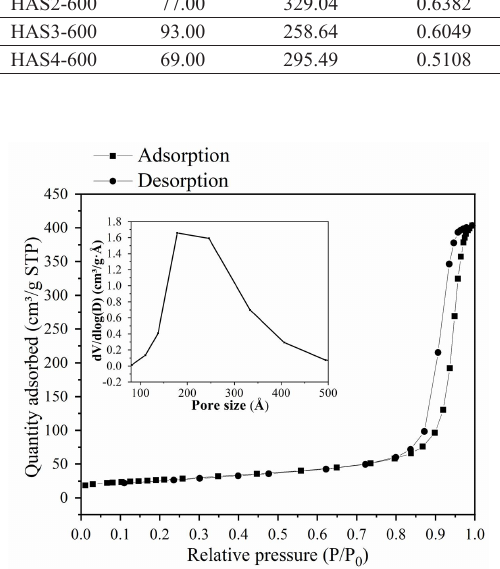
of the HAS3.600 2